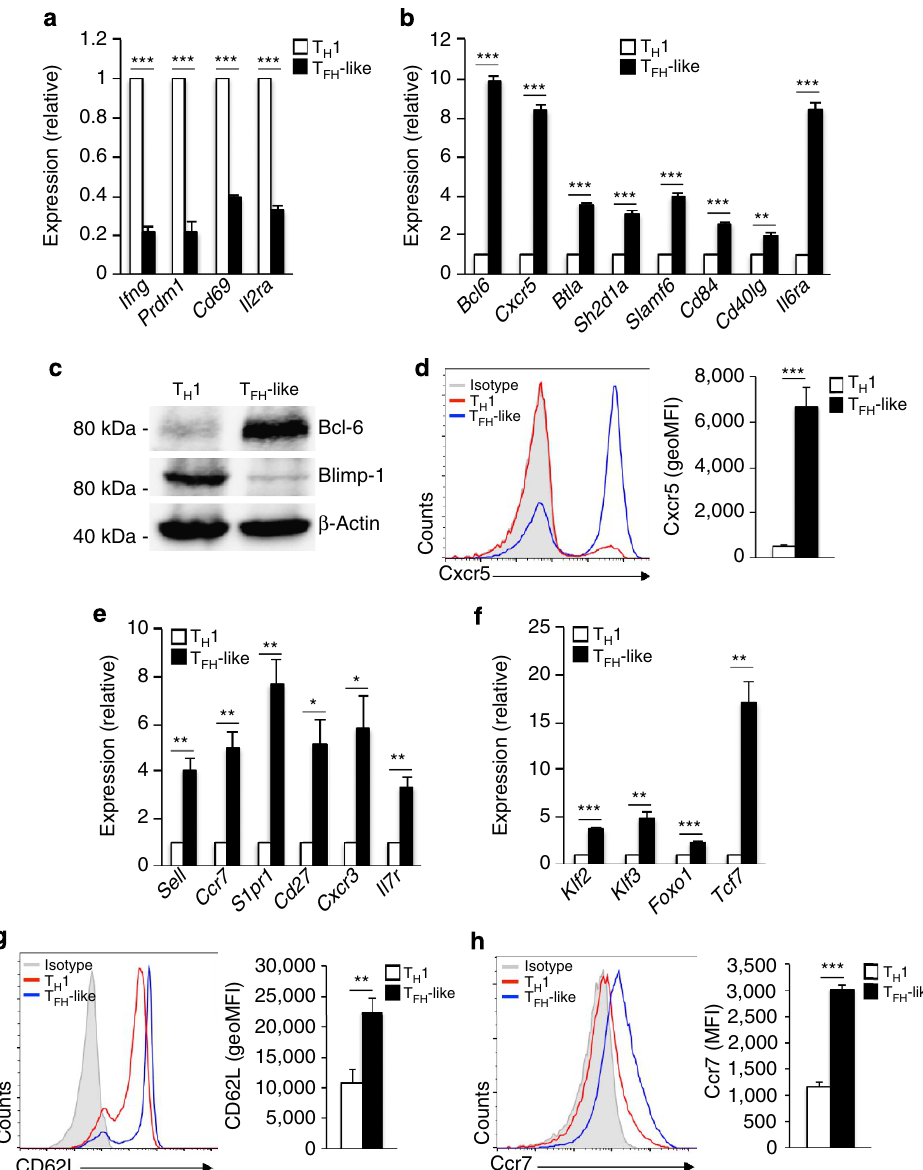
Figure 1 | IL-2 signalling regulates Bcl-6 expression in post-effector T H 1 cells to allow for the upregulation of T FH - and T CM -like profiles. Primary CD4 þ Tcells were cultured in T H 1 conditions and exposed to either high (T H 1 cells) or low (T FH -like cells) environmental IL-2 (250Uml (cid:2) 1 or 10Uml (cid:2) 1 , respectively). ( a , b ) RNA was isolated from the T H 1 (white bar) and T FH -like (black bar) cells and the expression of the indicated genes was determined by quantitative RT–PCR. Data were normalized to Rps18 as a control and the results are represented as fold change in expression relative to the T H 1 sample (mean of n ¼ 3 ± s.e.m.). ( c ) An immunoblot analysis was performed to assess changes in protein expression in response to alterations of environmental IL-2. Expression for Bcl-6 and Blimp-1 was measured with b -actin serving as a control for equal protein loading. Shown is a representative blot of three independent experiments performed. ( d ) Representative histogram overlay of cell surface expression of Cxcr5 for T H 1 and T FH -like cells. Geometric mean fluorescence intensity (geoMFI) for Cxcr5 is also shown (mean of n ¼ 5 ± s.e.m.). ( e , f ) qRT–PCR analysis examining expression of the indicated genes in T H 1 and T FH -like cells. Data were normalized and represented as in a and b (mean of n ¼ 3 ± s.e.m.). ( g , h ) Representative histogram overlay of cell surface expression of ( g ) CD62L and ( h ) Ccr7 for T H 1 and T FH -like cells. Average geoMFI or MFI for CD62L and Ccr7 expression are shown (mean of n ¼ 5 or 4 ± s.e.m.). * P o 0.05, ** P o 0.01, *** P o 0.001 (unpaired Student’s t -test). was significantly increased (Fig. 1f). Similar to Bcl-6, the the T FH -like profile, T H 1 cells exposed to a low IL-2 concentration expression of TCF-1 has been implicated in the development also upregulated genes associated with the T CM cell type—most notably the lymph node homing receptors Sell and Ccr7 of both T FH and memory cells 34–38 . Importantly, the induction of the T CM -like profile was not limited to changes in transcript (Fig. 1e) 1,2,33 . We also observed increased expression of other memory T-cell-related markers ( Il7r, S1pr1 , Cd27 and Cxcr3 ) and alone, as the cell surface expression of both CD62L and Ccr7 was transcription factors known to promote the memory T-cell fate significantly increased compared with that observed in effector ( Klf2 , Klf3 and Foxo1 ; Fig. 1e,f). Interestingly, the expression of T H 1 cells (Fig. 1g,h). Collectively, these data demonstrate that increased Bcl-6 expression in T H 1 cells, in response to decreased Tcf7 , the gene that encodes the transcriptional regulator TCF-1, NATURE COMMUNICATIONS|7:10285|DOI: